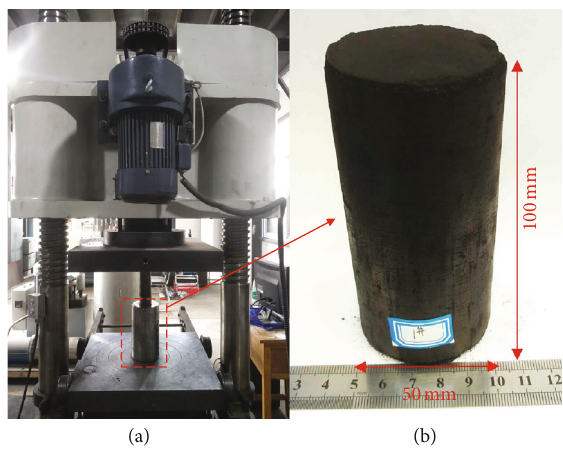
Figure 1: The process of making a